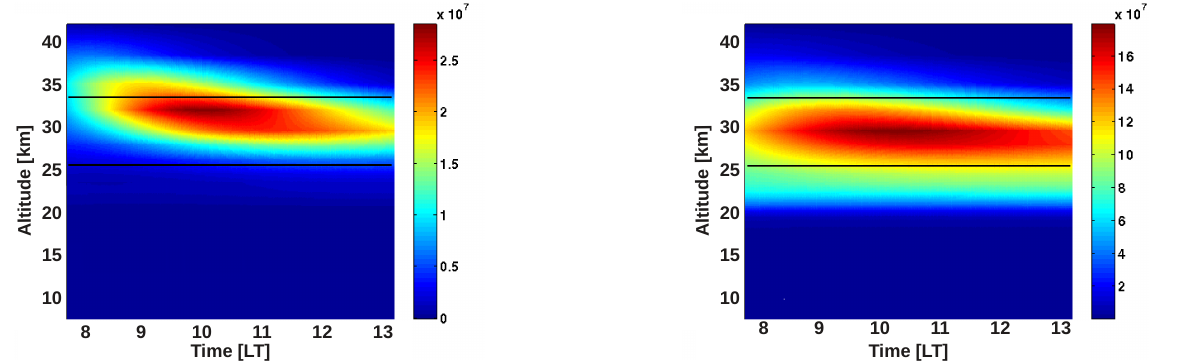
Figure 5. Sensitivity of the NO 2 concentration in our model to the scaling factors s 1 (left panel) and s 2 (right panel) on the absorption cross section of N 2 O 5 . Units are given in 10 7 moleccm − 3 . The altitude region used for the analysis is marked by black lines.